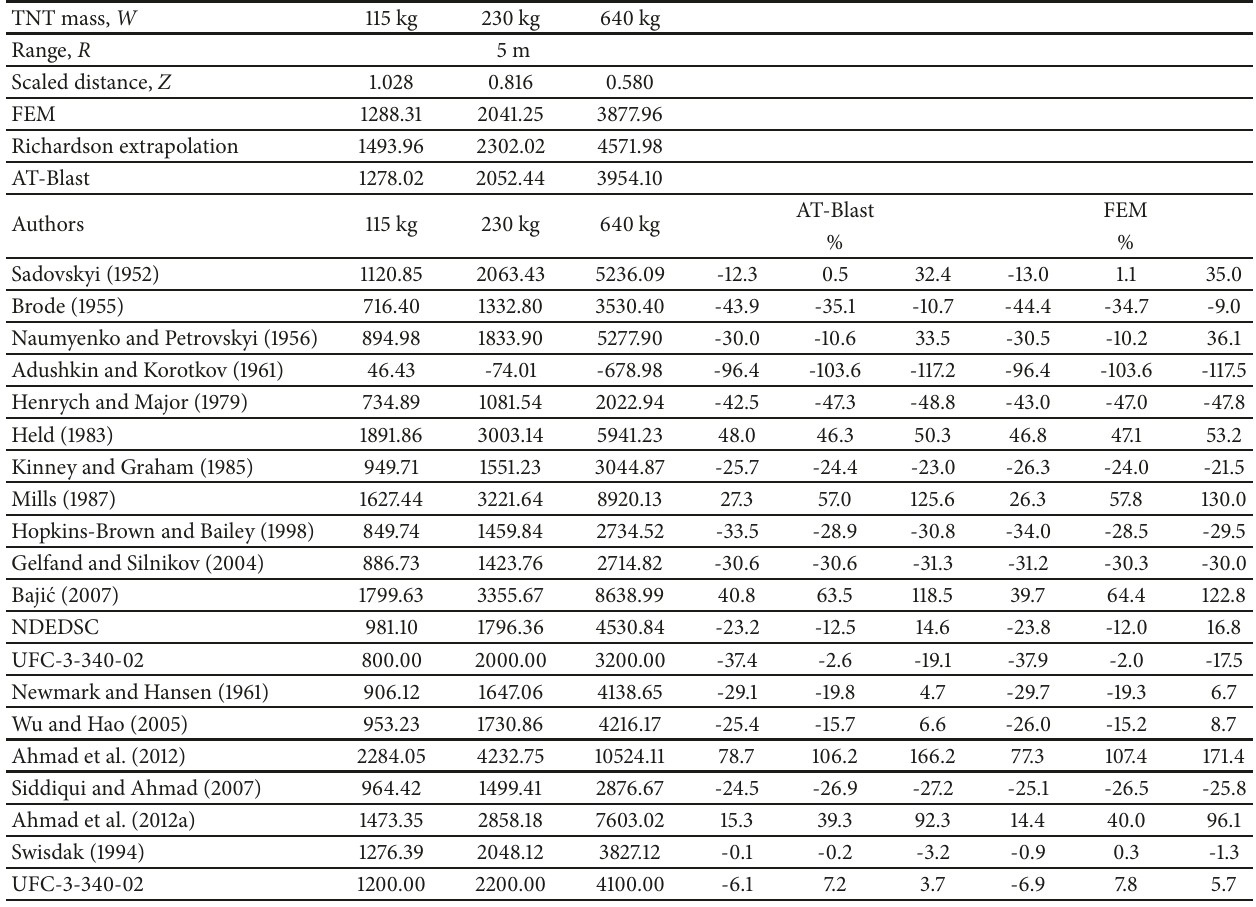
Table 11: Comparison of analytical expressions with AT-Blast and FEM overpressures [kPa].